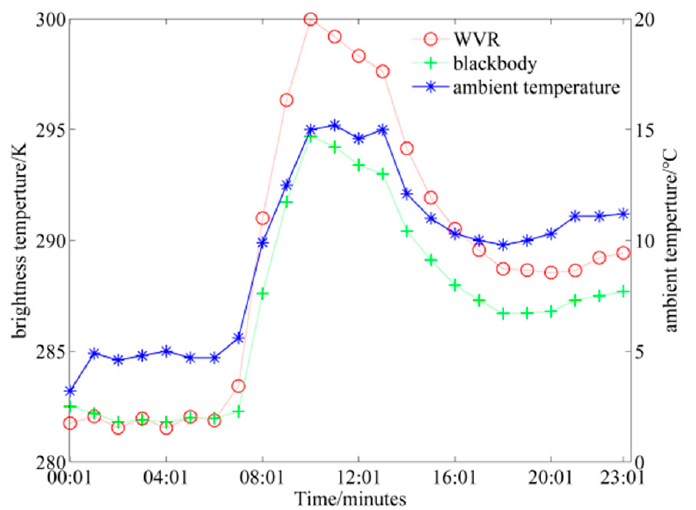
Figure 3. The brightness temperature of the water vapor radiometer at 23.8 GHz frequency and the brightness temperature of the black body were measured when the ambient temperature changed.